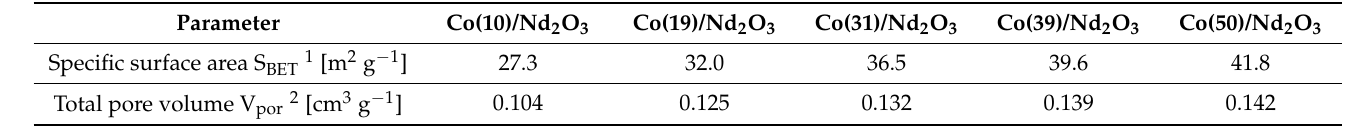
Table 1. Textural parameters of cobalt catalyst